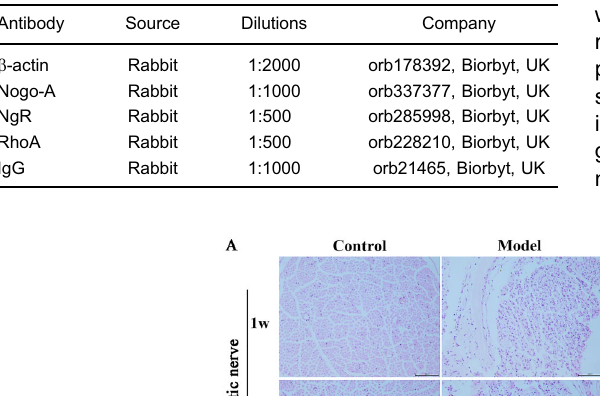
Braz J Med Biol Res | doi: